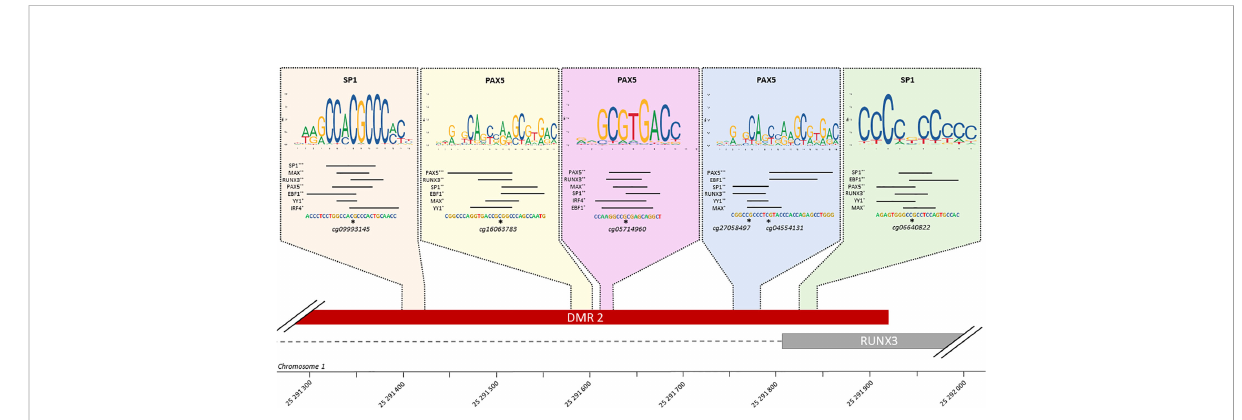
FIGURE 6 TFBS affected by methylation in RUNX3 regulatory region. Schematic representation of all TFBS found in RUNX3 regulatory region, using FIMO and Jaspar database. For each TFBS region, all the transcription factor predicted as affected by a differentiation of methylation in this region are rank by FIMO pvalue (***pvalue ≤ 0.001, **pvalue ≤ 0.01, *pvalue ≤ 0.05). The top-rank TF binding pro fi le is shown, as well as the differentially methylated position in the